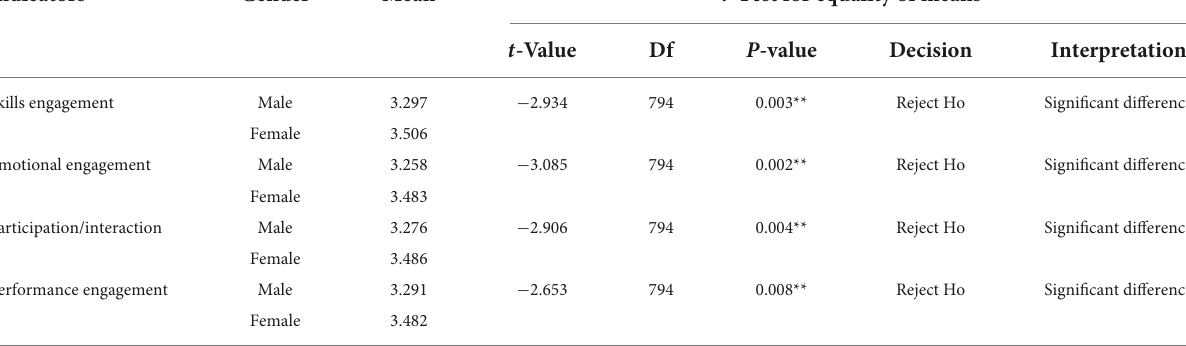
TABLE 4 Differences in the engagement of computer science college students in terms of gender. Indicators